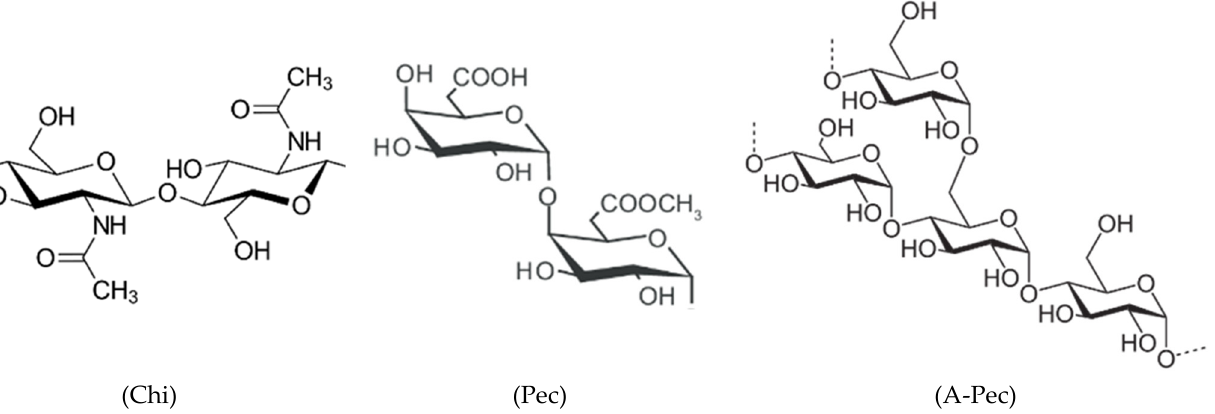
Figure 1. Structures of repeating units of chitin (Chi), pectin (Pec), and amylopectin (A-Pec).